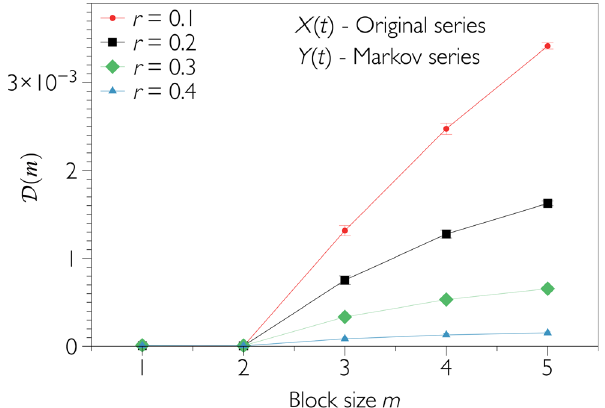
FIG. 7. The normalized Kullback-Leibler divergence D ð m Þ between X ð t Þ and its Markovian surrogate Y ð t Þ , in the case where X ð t Þ does not show any induced current, for different values of the switching rate r . The series X ð t Þ records the position of a walker diffusing over two layers, where transition proba- 1 Þ 2 Þ bilities in the layers are T ð ¼ 1 = 3 and T ð ¼ 2 = 3 . We i;i þ 1 i;i þ 1 correctly find that X ð t Þ is non-Markovian even for large values of r as D ð m > 2 Þ > 0 , which suggests an underlying multiplex